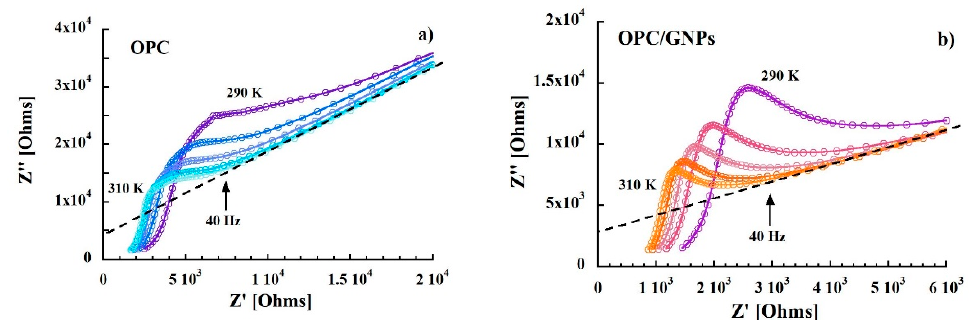
Figure 2. Nyquist plot of the impedance of OPC ( a ) and OPC / GNPs ( b ). Dashed line is the extrapolation to high frequencies of the cement-electrode interface contribution.